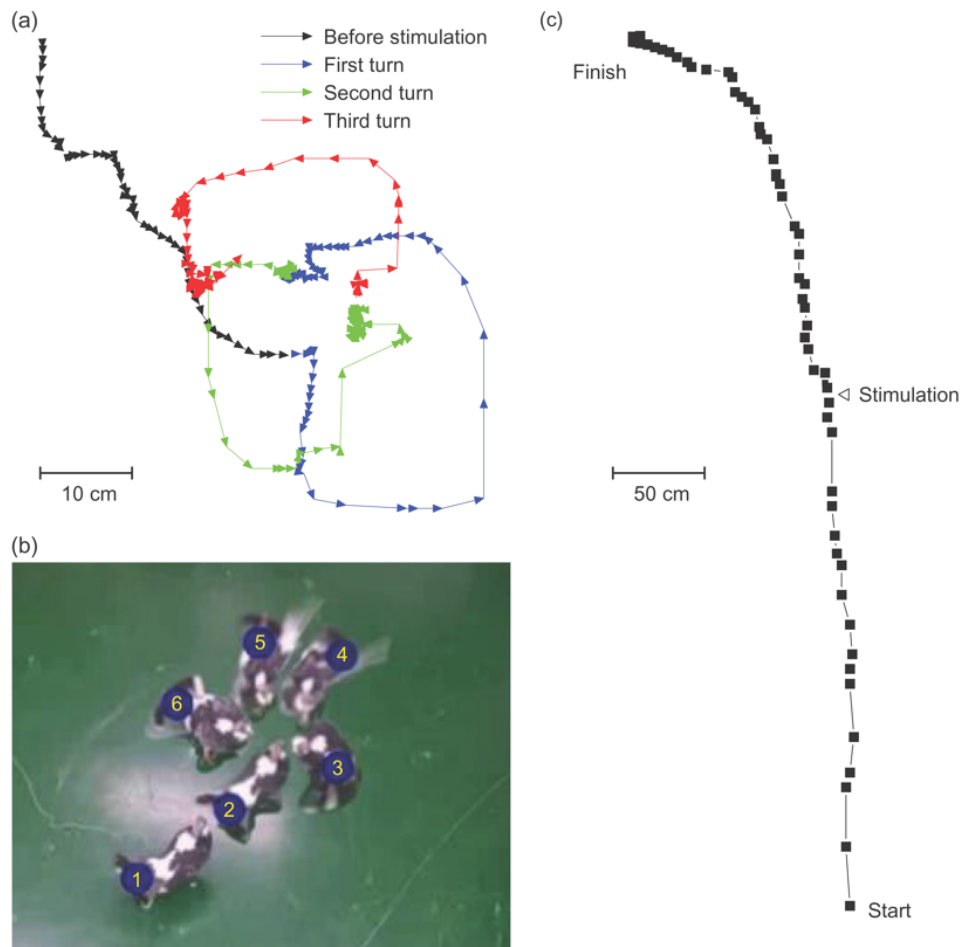
Figure 5. Behavioral changes on electrical current stimulation of the midbrain nucleus. A pigeon with a marker in its tail showed ( a ) the counterclockwise, leftward body turn on the ground during stimulation. It showed three consecutive turns in a single stimulation session. ( b ) stroboscopic image of the leftward body turn on the ground. ( c ) The trajectory of the leftward flight in the outdoor aviary was induced by electrical stimulation.